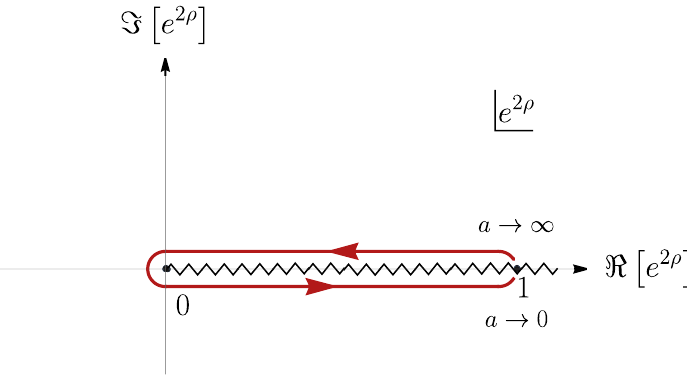
Figure 7 . The path traversed in the complex plane by the cross ratio e 2 ρ as a moves from greater to one to less than one. e 2 ρ (and so z ) circles round the branch point at zero in a counter-clockwise